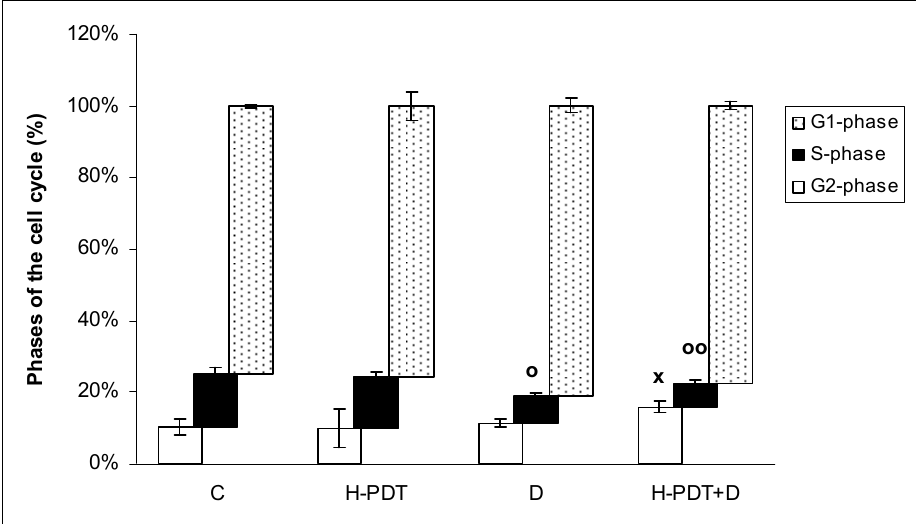
Figure 2. The effect of PDT with hypericin (H-PDT), 17-DMAG (D) and their combination (H-PDT + D) on the cell cycle progression of SKBR-3 cells. The cells were untreated (C) or treated for 24 h with hypericin (21 nM), 17-DMAG (5 nM) or their combination under dark conditions, photoactivated and consequently analyzed 24 h